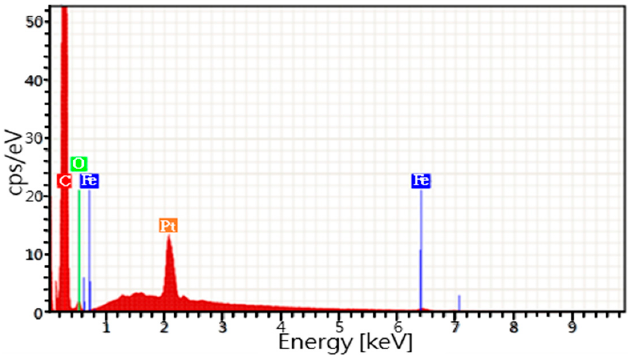
Figure 8. EDS analysis results for the carbon nanotube-iron phthalocyanine composite.